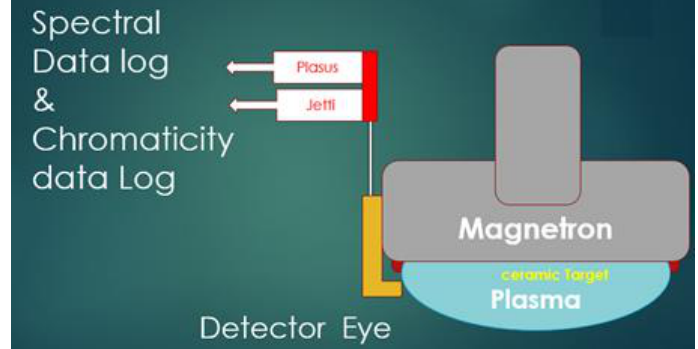
Figure 2. An in-vacuum collimator optic (detector eye) was placed adjacent to the magnetron fitted with a six-inch indium zinc oxide (IZO) target, and the emission data were transferred to the spectrometers via quartz fiber; the distance between the collimator and target edge was 4 cm. The distance between the target surface and substrate (center to center) was 15 cm at 45°